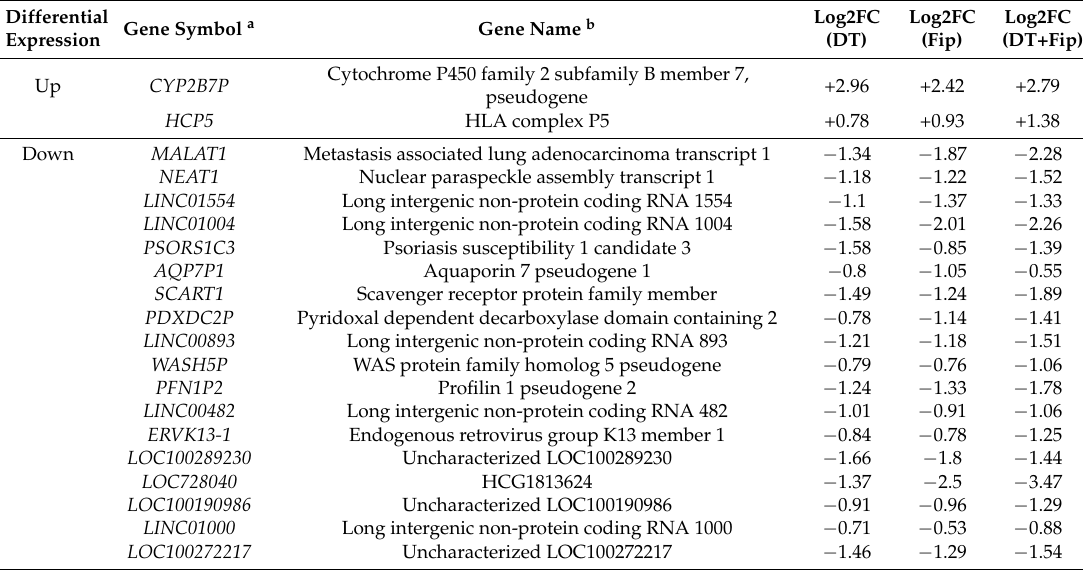
Table 1. Long non-protein coding RNAs (lncRNAs) whose transcripts were significantly ( p ≤ 0.01) differentially expressed (Diff. Exp.; up (+) or down ( − ) regulated) in primary human hepatocytes